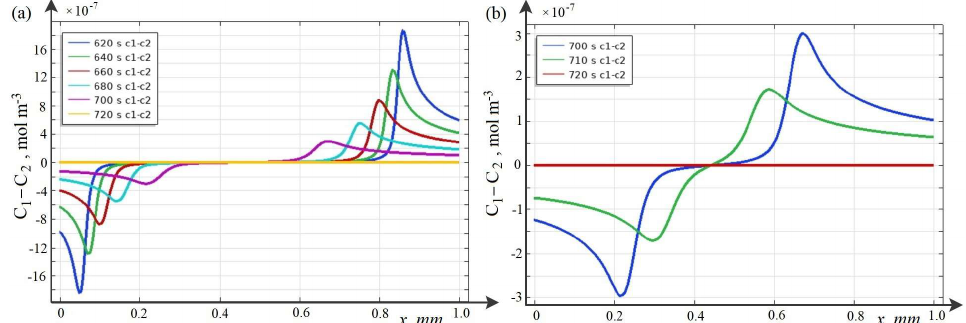
Figure 4. Breakdown phenomenon for a KCl solution with initial concentration C 0 = 10 mol · m − 3 . Space charge graphs normalized to Faraday numbers at different time intervals: ( a ) before breakdown, and ( b ) before and after breakdown.